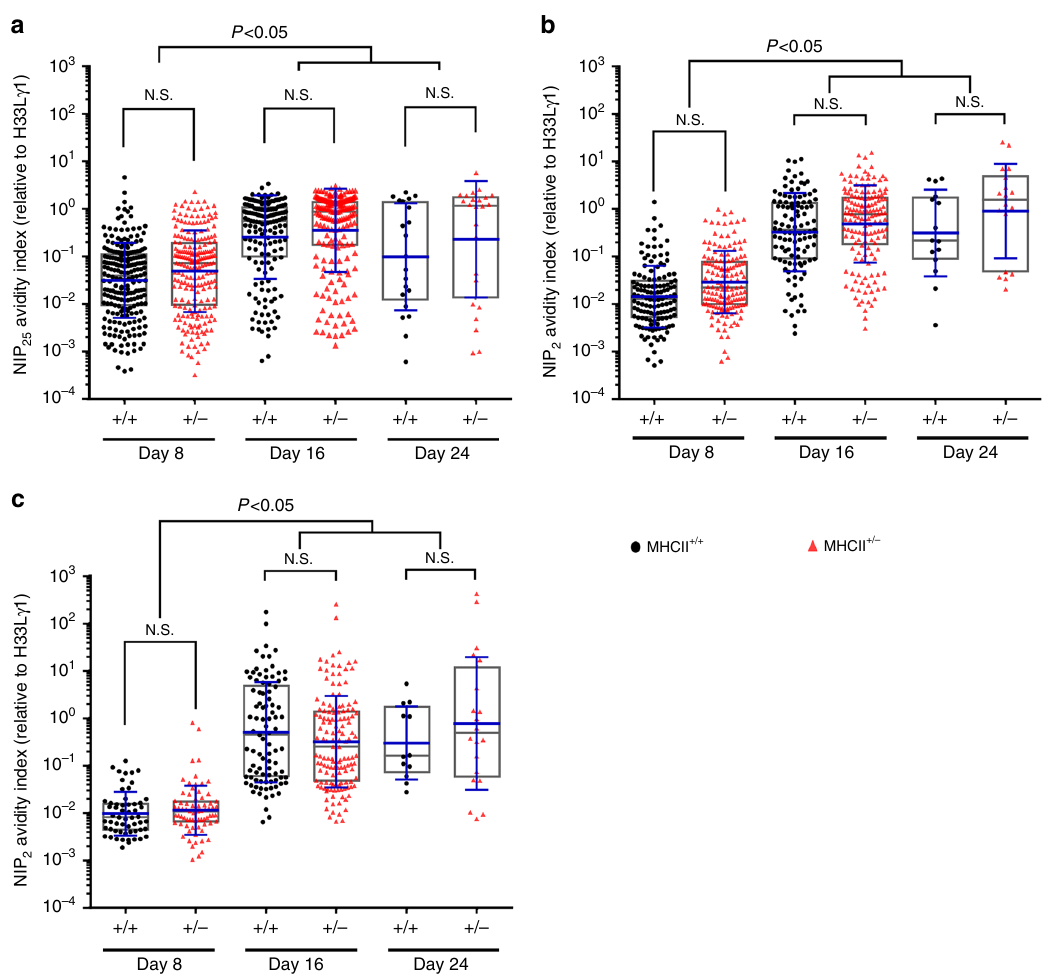
Fig. 5 Competing MHCII + / + and MHCII + / − B cells show identical af fi nity maturation. Single-cell, Nojima cultures were established from splenic GC B cells isolated from BM chimeric mice at days 8, 16, and 24 post immunization (Fig. 3a). a NIP 25 -, b NIP 2 -, and c NP 2 -speci fi c AvIn values (relative to the H33L γ 1 standard) are shown. Each symbol (MHCII + / + , black circles; MHCII + / − , triangles) represents the AvIn value of one IgG + clonal culture sample ( n = 12 – 220, Table 1). Boxes represent the 25th, 75th percentiles and median. Bars (blue) indicate the geometric mean and ±S.D. Statistical signi fi cance ( P < 0.05) was measured using two-way ANOVA with Friedman test followed by Dunn ’ s multiple comparison post tests. N.S. not signi fi Stability in the ratios of MHCII + / + :MHCII + / − GC B cells did not re fl ect anatomical segregation as histologic studies con fi rmed that all GCs were populated by both MHCII + / + and MHCII + / − B